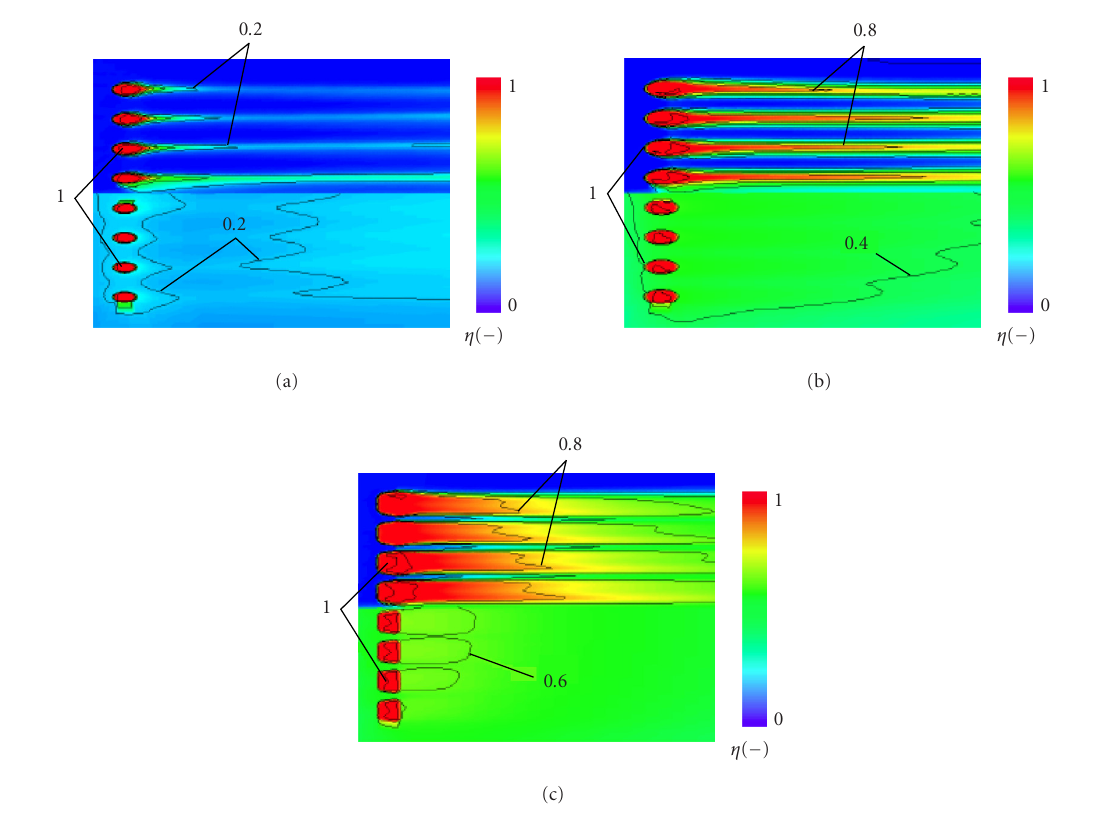
Figure 4: Cooling e ff ectiveness distribution on the wall surface ( M = 2 . 0, ∆ η iso = 0 . 2): (a) cylindrical hole, (b) di ff user hole, and (c) fanshaped